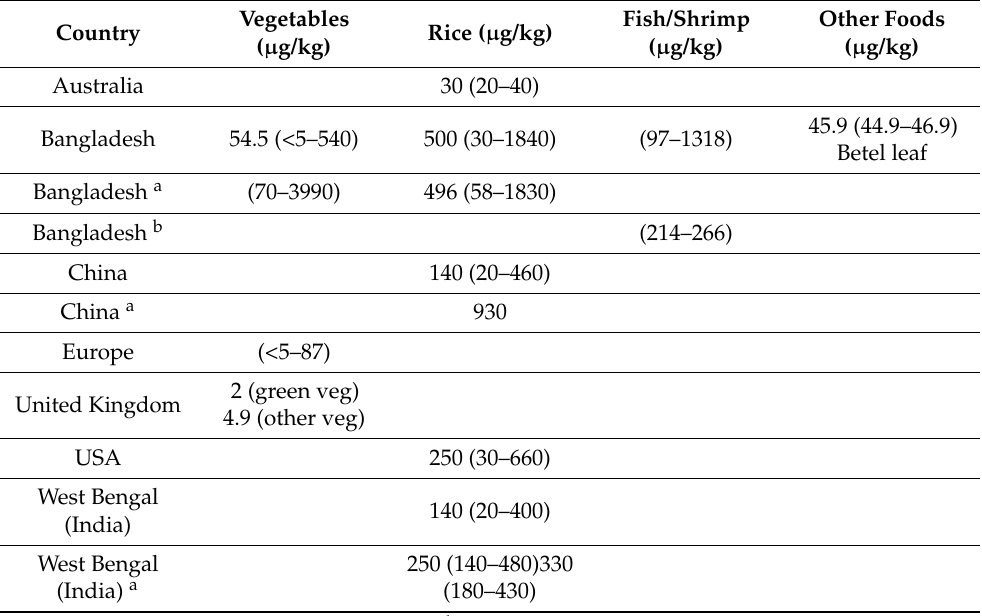
Table 2. Concentrations of arsenic in selected foods from different